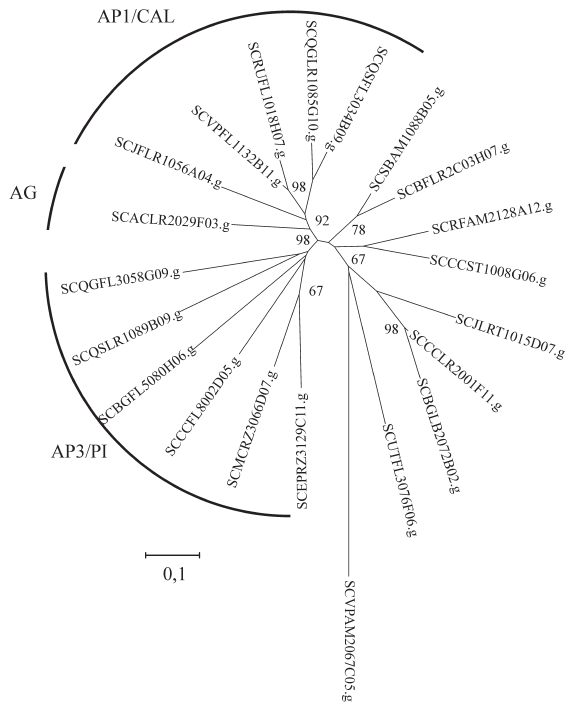
Figure 3 - Phylogenetic relationships among sugarcane nucleotide se- quences coding for the MADS-box domain. The most parsimonious con- sensus tree had its branches scaled to the corresponding genetic distances and is shown in its radial form. Only Bootstrap values (1000 replicates) higher than 75% are